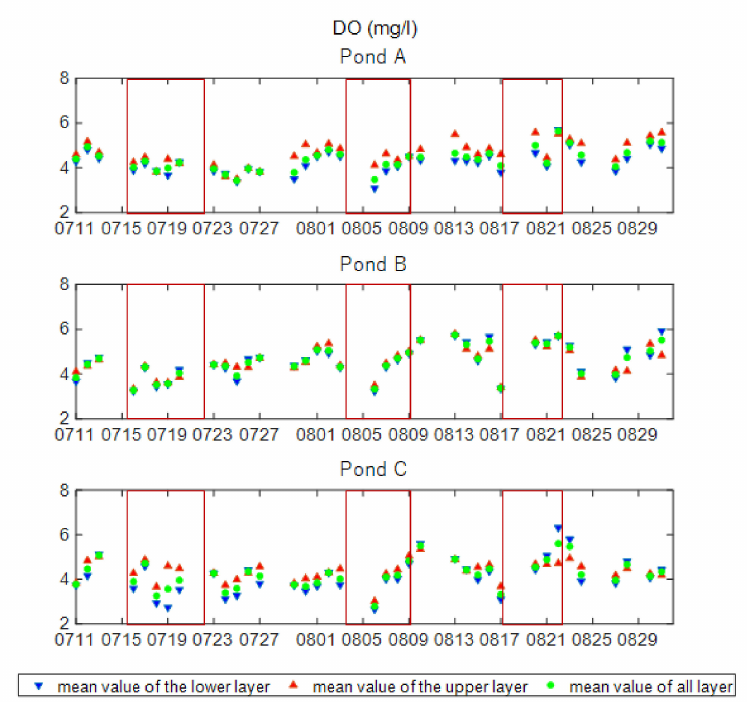
Figure 8. Mean DO value for the lower layer, upper layer, and all layers.